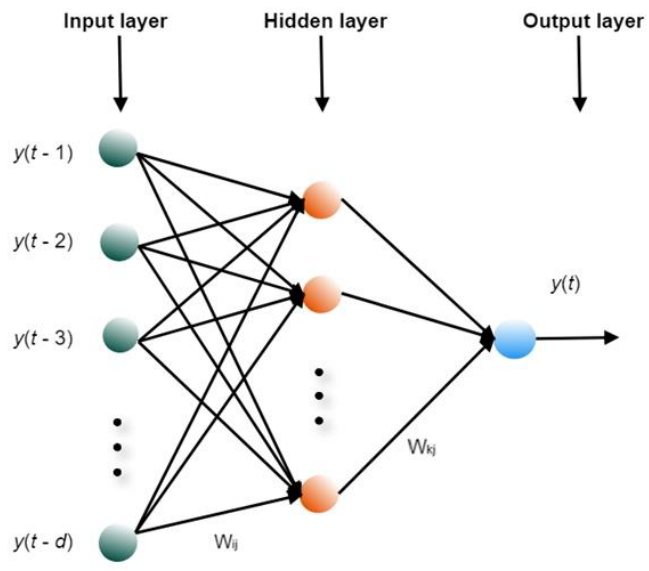
Figure 1. The general architecture of the NAR neural network.